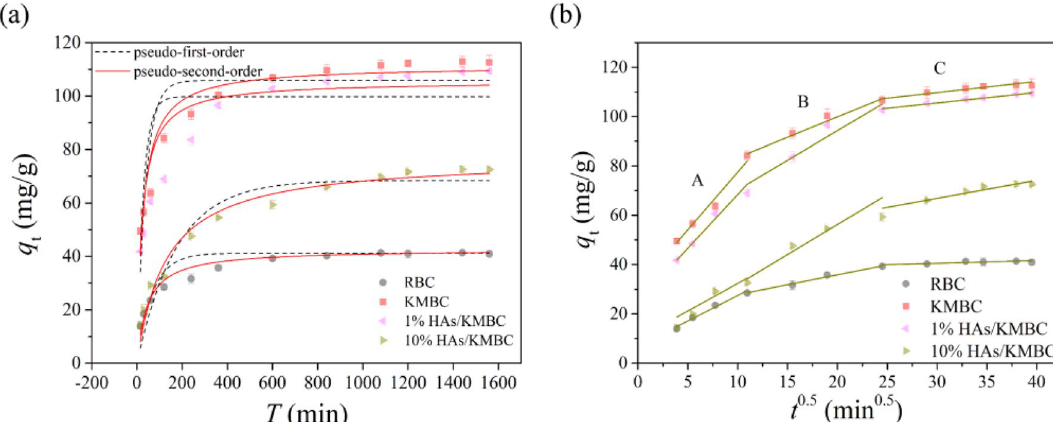
Figure 3. Adsorption kinetic curves of TC onto RBC, KMBC, 1% HAs/KMBC and 10% HAs/KMBC: ( a ) the solid lines and dotted lines are the pseudo-second-order model and the pseudo-first-order model simulation, respectively; ( b ) Intra-particle diffusion model simulation. C 0(TC) = 50 mg/L, m / V = 0.1 g/L, T = 25 °C, pH =